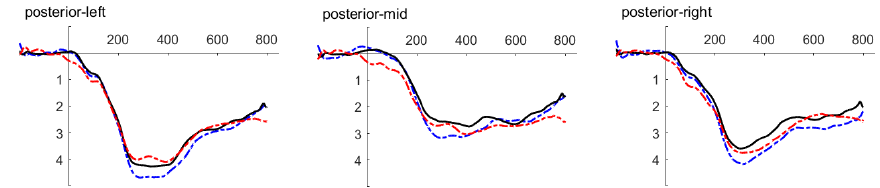
Figure 7. Grand average ERPs plotted for the high-cure rate condition.